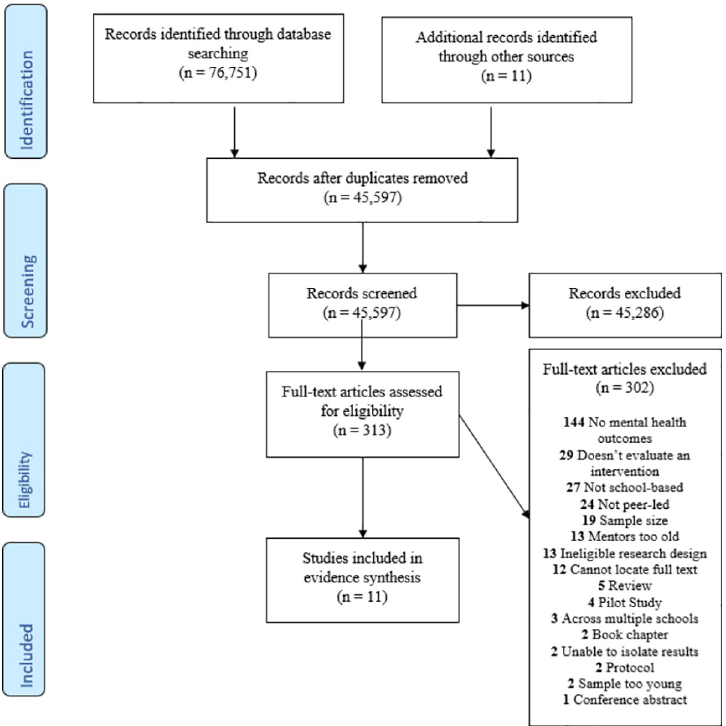
Fig 2. PRISMA 2009 flow diagram for systematic review. From : Moher D, Liberati A, Tetzlaff J, Altman DG, The PRISMA Group (2009). P referred R eporting I tems for S ystematic Reviews and M eta- A nalyses: The PRISMA Statement. PLoS Med 6(7): e1000097.